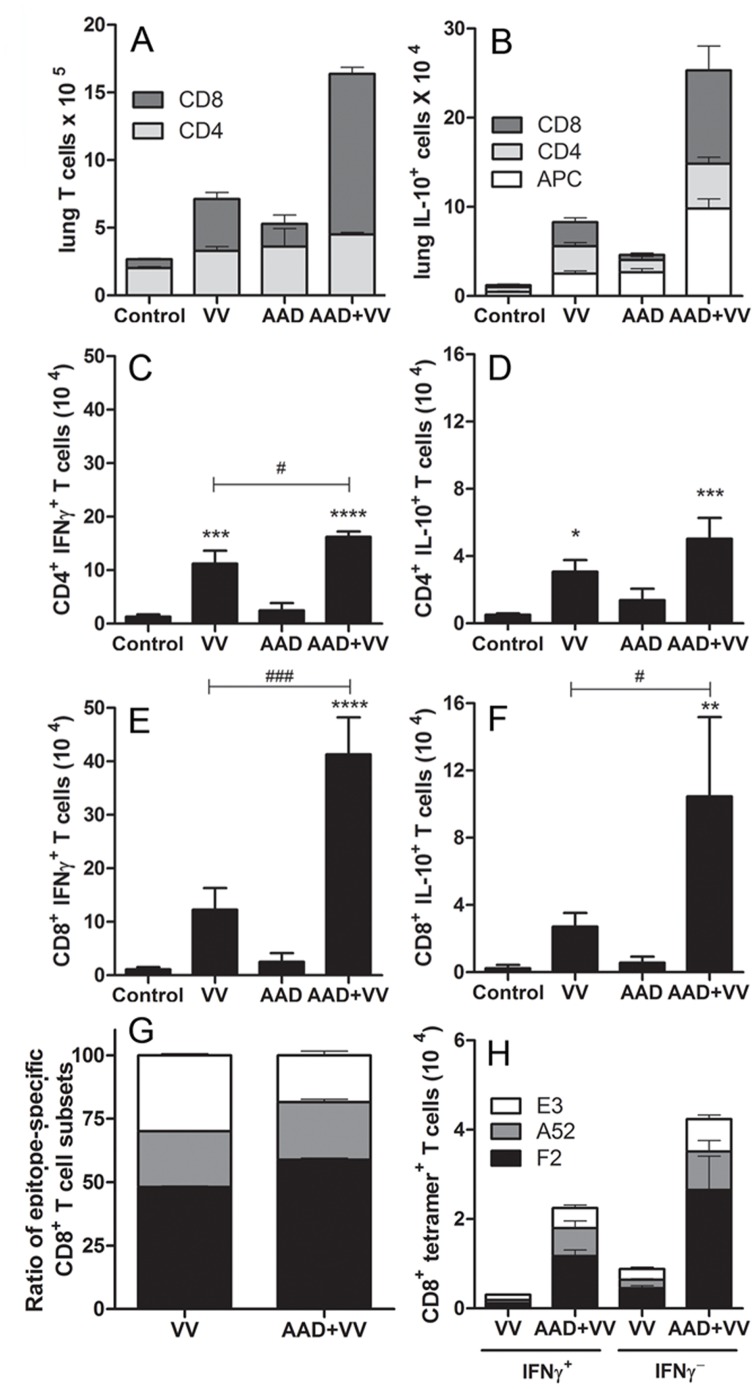
VV-infected AAD mice had increased CD8+ effector T cells in the lungs at 10 dpi.Lung tissue was harvested from mice 10 days after virus or mock inoculation. Single cell suspensions from individual animals were restimulated in vitro as described in the methods followed by antibody staining and flow cytometric analyses. The frequency of (A) CD4+ and CD8+, (B) IL-10+ (C) CD4+ IFNγ+, (D) CD4+ IL-10+, (E) CD8+ IFNγ+ and (F) CD8+ IL-10+ infiltrating lung T cells was determined by cell counts and FACS analysis using commercial antibodies as outlined in the methods. (G–H) Epitope-specific CD8+ T cells were determined by MHC I tetramer staining for H-2 class I epitopes (Dd: E3 epitope; Kd: A52 epitope; Ld: F2 epitope) and FACS analysis (white bar E3, gray bar A52, black bar F2). Cells from dissociated lung tissue were restimulated in vitro and tetramer-stained as detailed in the methods. (G) Ratio of epitope-specific CD8+ T cells normalized to total CD8+ tetramer+ T cells. (H) Frequency of epitope-specific CD8+ T cells with or without IFNγ co-expression was determined. Statistical significance was determined by a One-way ANOVA with Bonferroni’s multiple comparisons test *P<0.05, **P<0.01, ***P<0.001, ****P<0.0001 AAD+VV vs. control; #
P<0.05, ###
P<0.001 AAD+VV vs. VV. Results are expressed as mean ± SEM for (A–F) six mice in each group and are representative of 2 independent experiments or (G–H) 4–5 mice in each group.